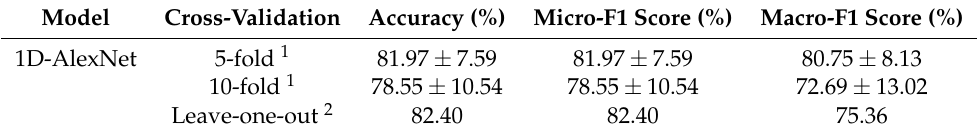
Table 1. Performance measures of the 1D-AlexNet model: accuracy, micro- and macro-average F1 scores. Average cross-validated scores across all subsections of the